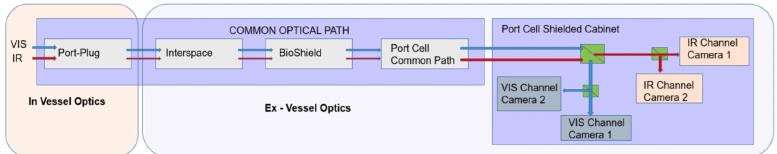
Figure 21. Block diagram of WAVS operation. Reprinted with permission from Ref. [121]. Credit c (cid:13) Elsevier,